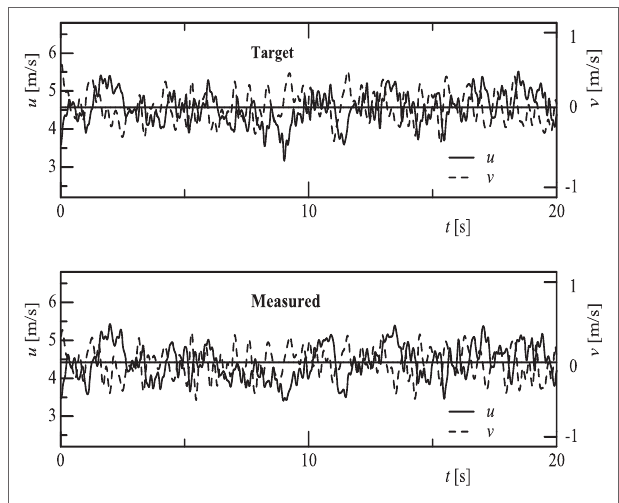
FigUre 2 | Comparison of target and reproduced wind speed